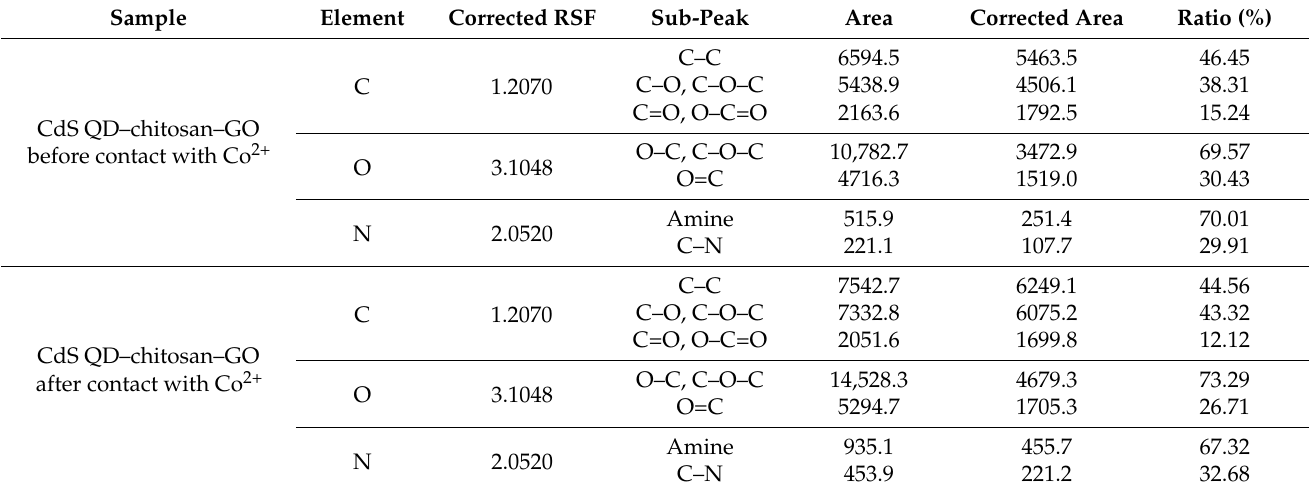
Table 7. Chemical composition ratios for C 1s, O 1s, and N 1s for the CdS QD–chitosan–GO thin film before and after contact with Co 2+